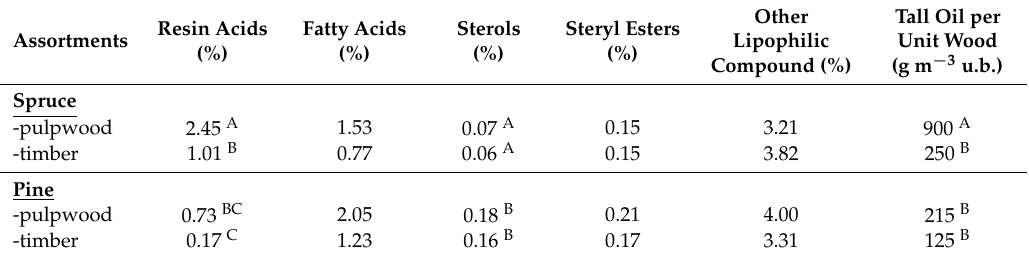
Table 1. The concentrations in dry weight of identified and other lipophilic extractives in bark, and the content of tall oil in bark per unit volume of wood from forestry assortments. Different letters after the values denote significant differences ( p ≤ 0.05, according to Analysis of Variance (ANOVA) with Tukey grouping) between bark sources. The number of samples was 8 for spruce timber, 4 for spruce pulpwood, 9 for pine timber and 3 for pine